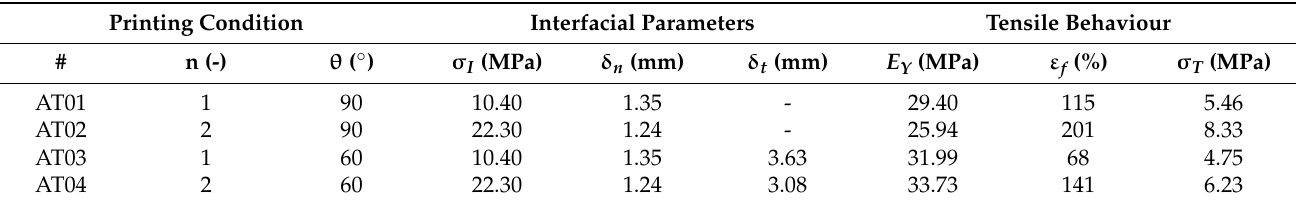
Table 2. Identification results of the interfacial behaviour as a function of the printing conditions.